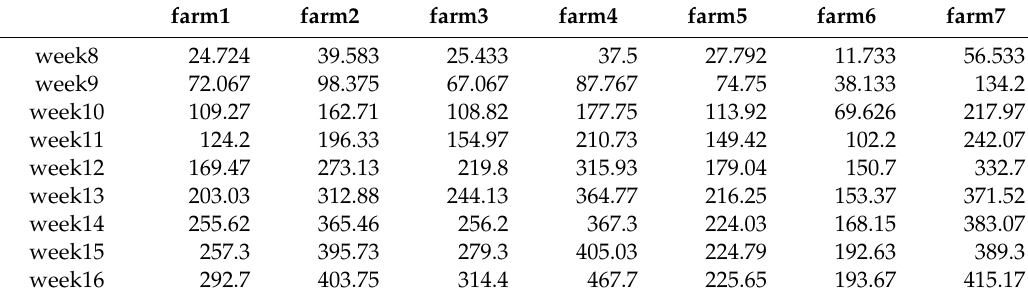
Table 3. Example of input data of onion weight of growth